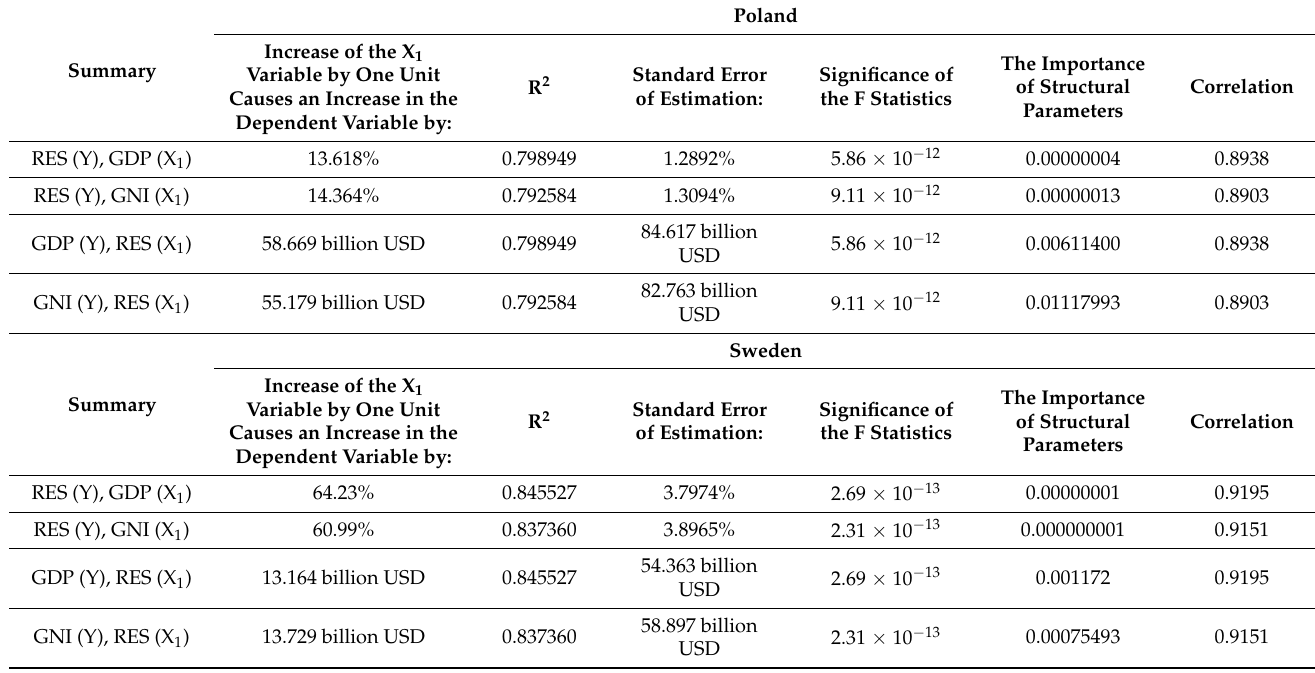
Table 8. Summary of the regression